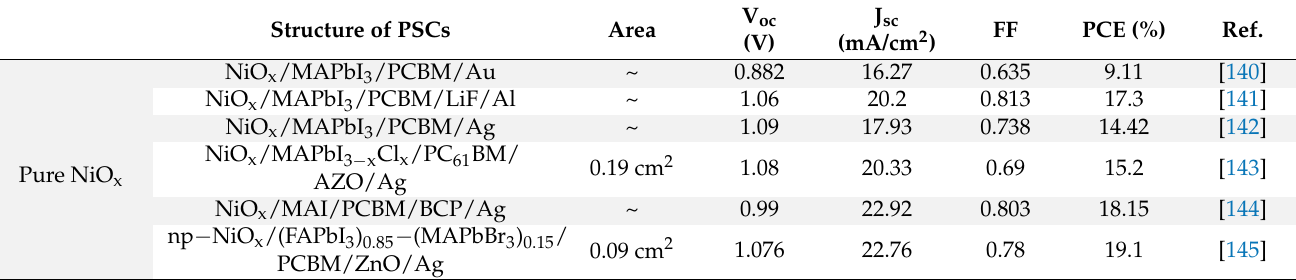
Table 12. Performances of several representative inverted PSCs on the basis of NiO x materials. Structure of